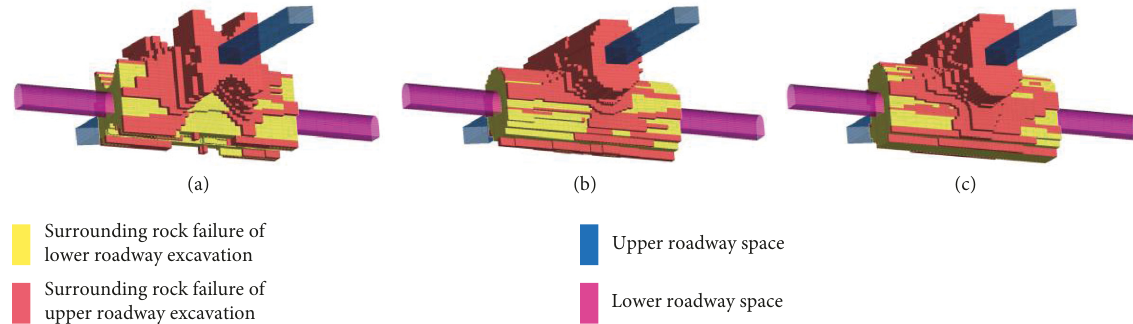
Figure 14: Disturbance influence of stress ratio on surrounding rock failure of staggered roadways. (a) 0.5 ratio of horizontal stress to vertical stress, (b) 1.0 ratio of horizontal stress to vertical stress, and (c) 1.5 ratio of horizontal stress to vertical stress.